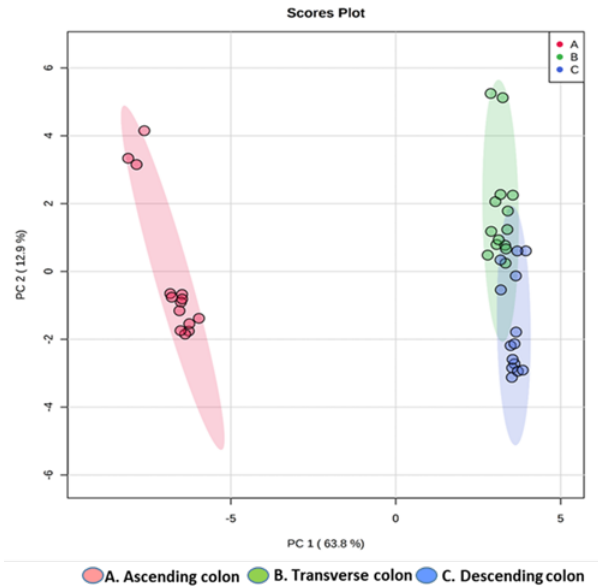
Figure 4. Principal component analysis (PCA) score plot of HPP-treated onion fermentation products. The parameters for these models were: R2 = 0.934, Q2 = 0.921. A Student’s t-test at 95% level ( p < 0.05) was used to select the most important variables in each model.